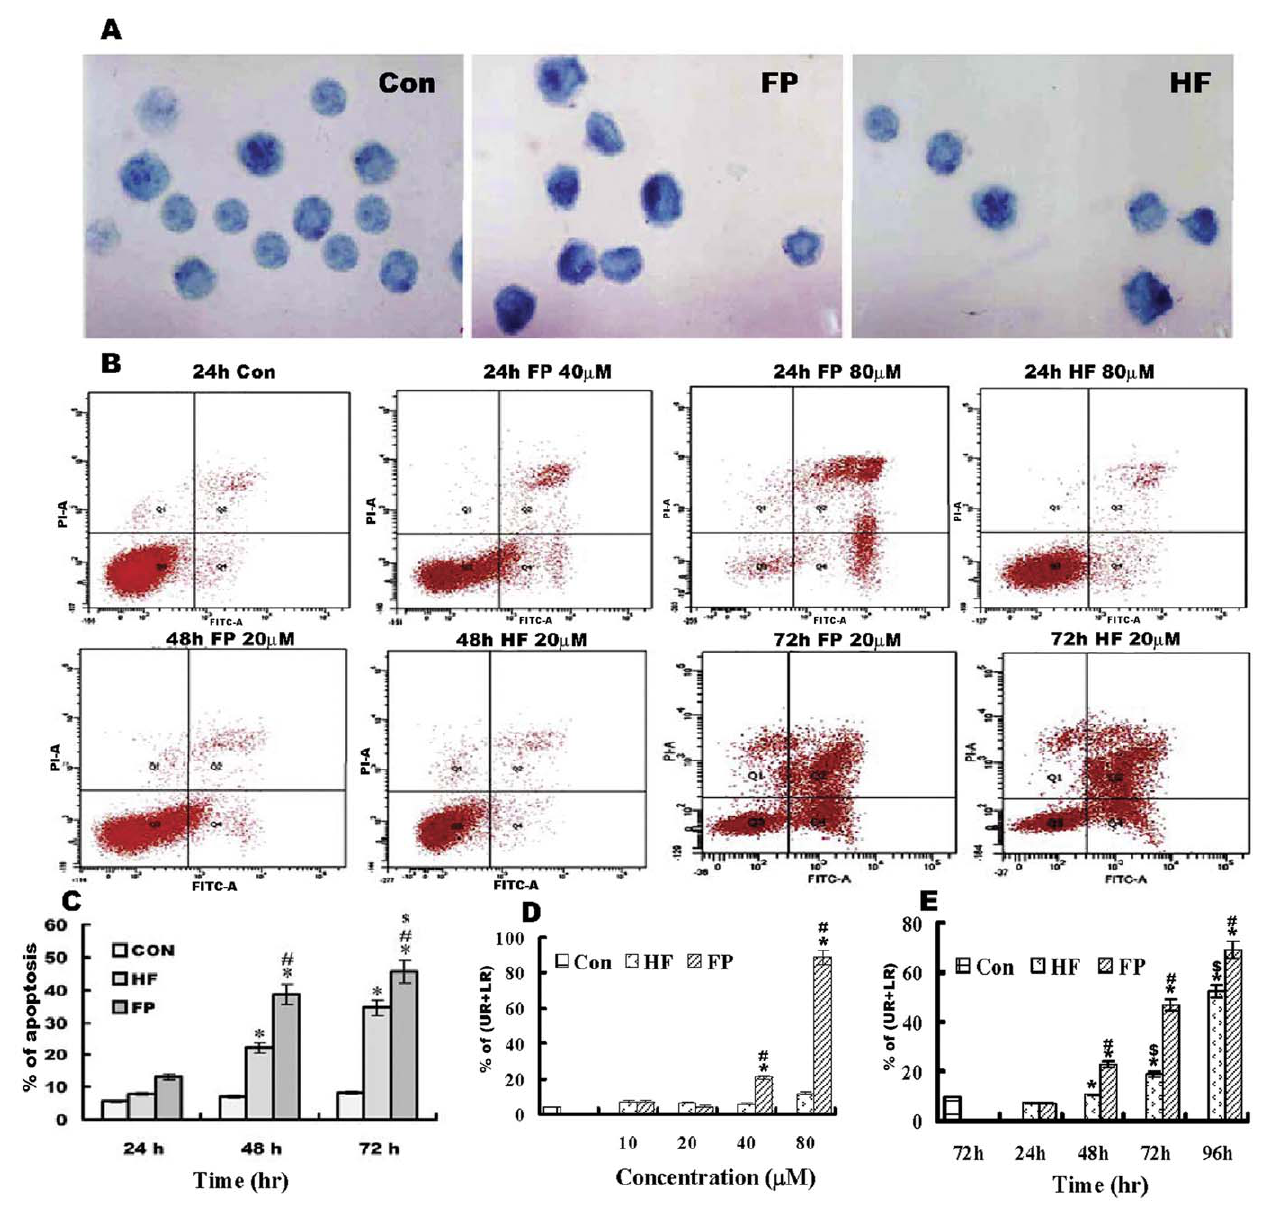
Figure 3. Effects of FP/HF on cell apoptosis. A) TUNEL staining for apoptosis in HeLa cells after treatment for 48 h in control, FP and HF groups; methyl green counter-stained, 1,000 6 . Control group, few apoptotic cells were found; FP group, more apoptotic cells were found. B) Quantitative analysis of apoptotic cells using Annexin V-FITC/PI double staining in exponentially growing HeLa cells. C) Apoptosis percentages in the different groups detected using the TUNEL method at 24, 48 and 72 h. D) Apoptosis percentages (upper right (UR) + lower right (LR)) in each group following treatment with 10, 20, 40 and 80 m M HF or FP detected by flow cytometry at 24 h. E) Apoptosis percentages (UR + LR) in each group analyzed by flow cytometry at 24, 48, 72 and 96 h. Flow cytometry was performed on 5 6 10 5 cells and the percentages of apoptotic, live, and dead cells were measured. Upper left (UL; Annexin V-FITC 2 /PI + ) represents dead cells, upper right (UR; Annexin V-FITC + /PI + ) represents late apoptotic plus necrotic cells, lower left (LL; Annexin V-FITC 2 /PI 2 ) represents live cells, and lower right (LR; Annexin V-FITC + /PI 2 ) represents early apoptotic cells. Data are given as means 6 SD and are representative of three separate experiments. * p , 0.01 versus control cells; # p , 0.01 versus HF group; $ p , 0.01 versus 24 h FP